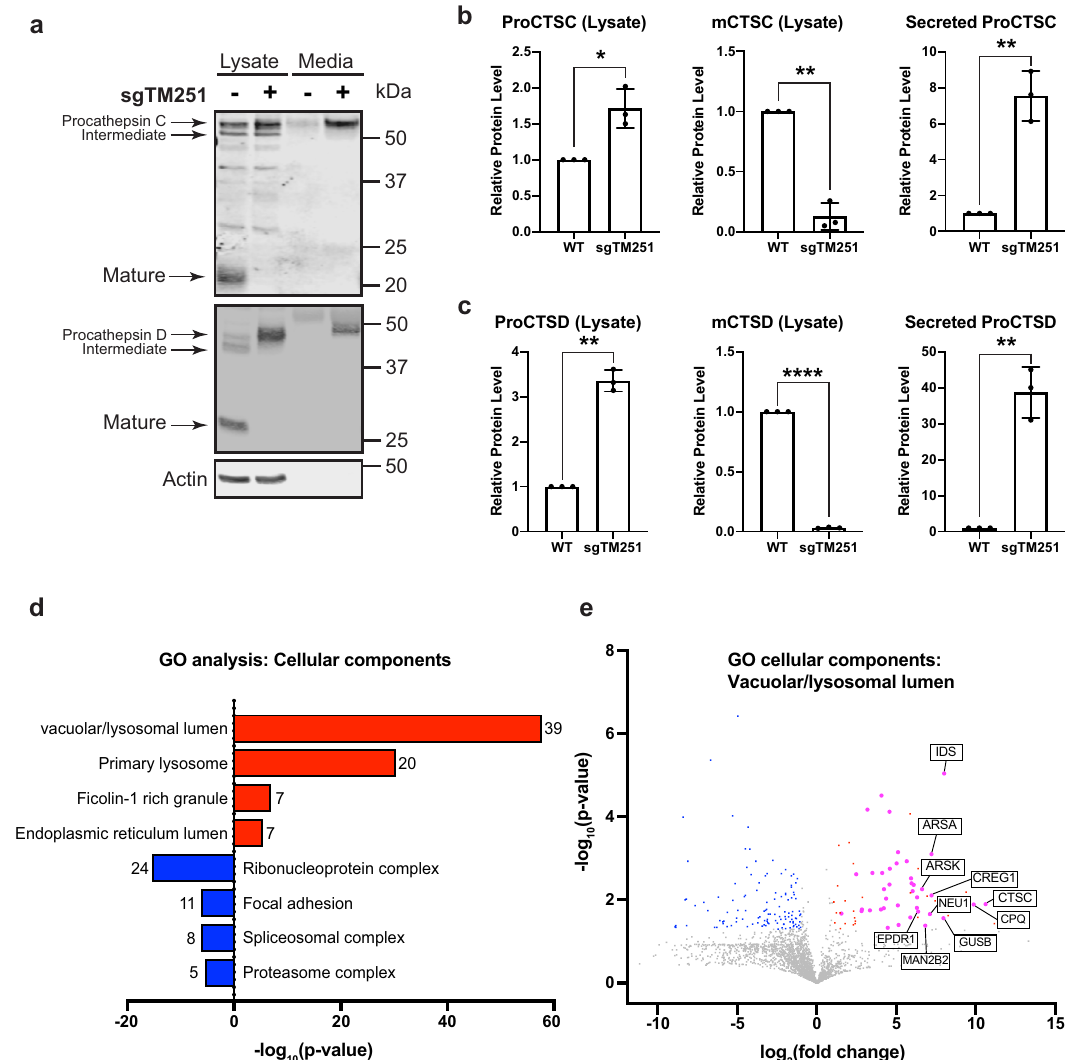
Fig. 4 | TMEM251 de fi ciency leads to hypersecretion of lysosomal enzymes. a CTSC and CTSD protein level in the whole cell lysate and conditioned media of HEK293 WT and sgTMEM251 cells. b , c Quanti fi cation of CTSC and CTSD protein levels in a . Mean of 3 independent replicates is shown. Error bars represent stan- dard deviation. * p ≤ 0.05, ** p ≤ 0.01, **** p ≤ 0.0001. See source data fi le for exact P values. d GO enrichment analysisof secreted proteins altered in sgTMEM251 ( n =3